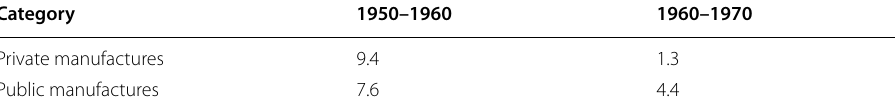
Table 5 Change rate in number of private and public manufactures (annual rate, unit: